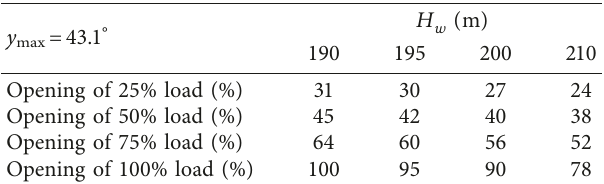
Table 2: The set value of guide vane opening at different water heads and loads.